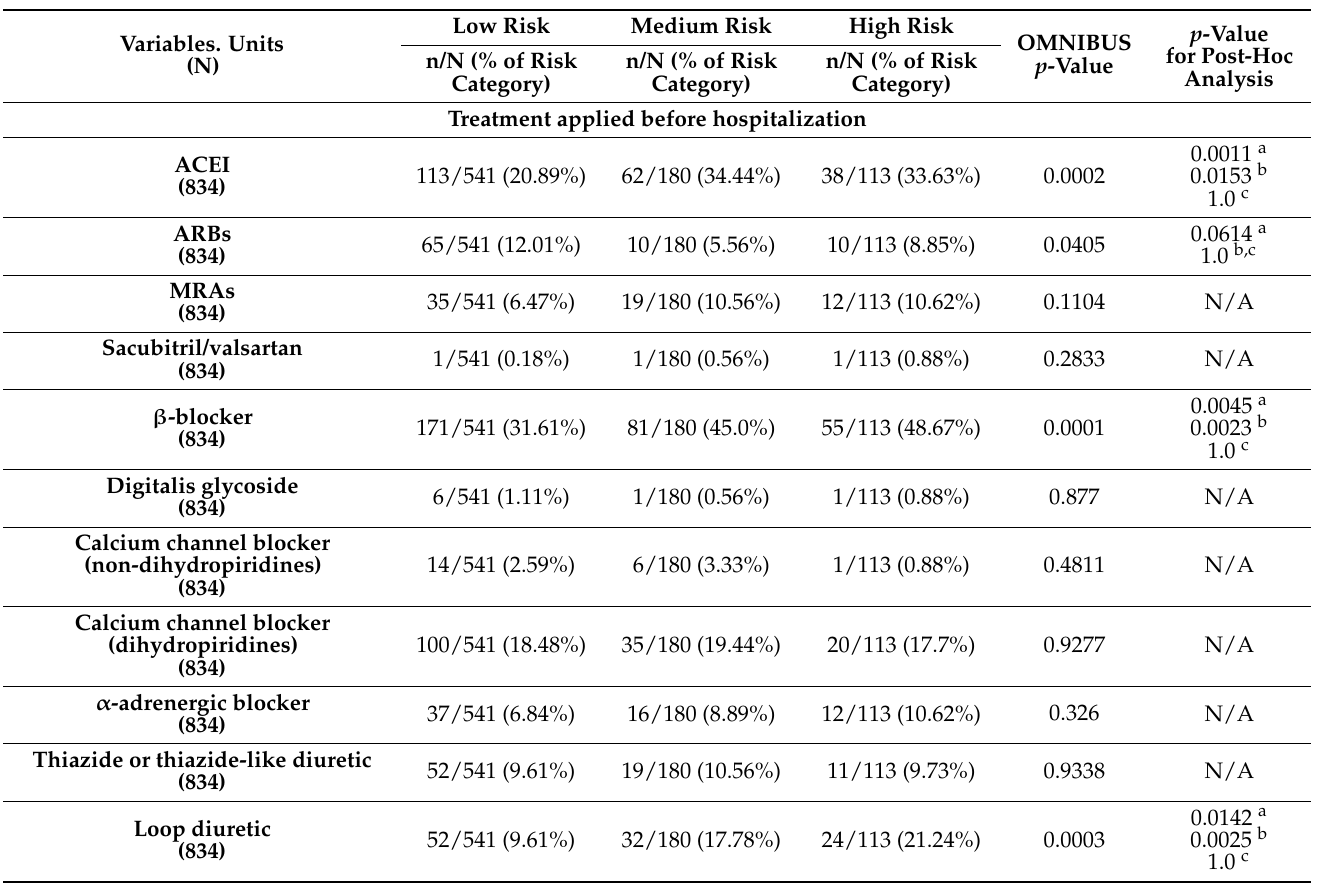
Table 2. Baseline characteristics of the study cohort—treatment applied before